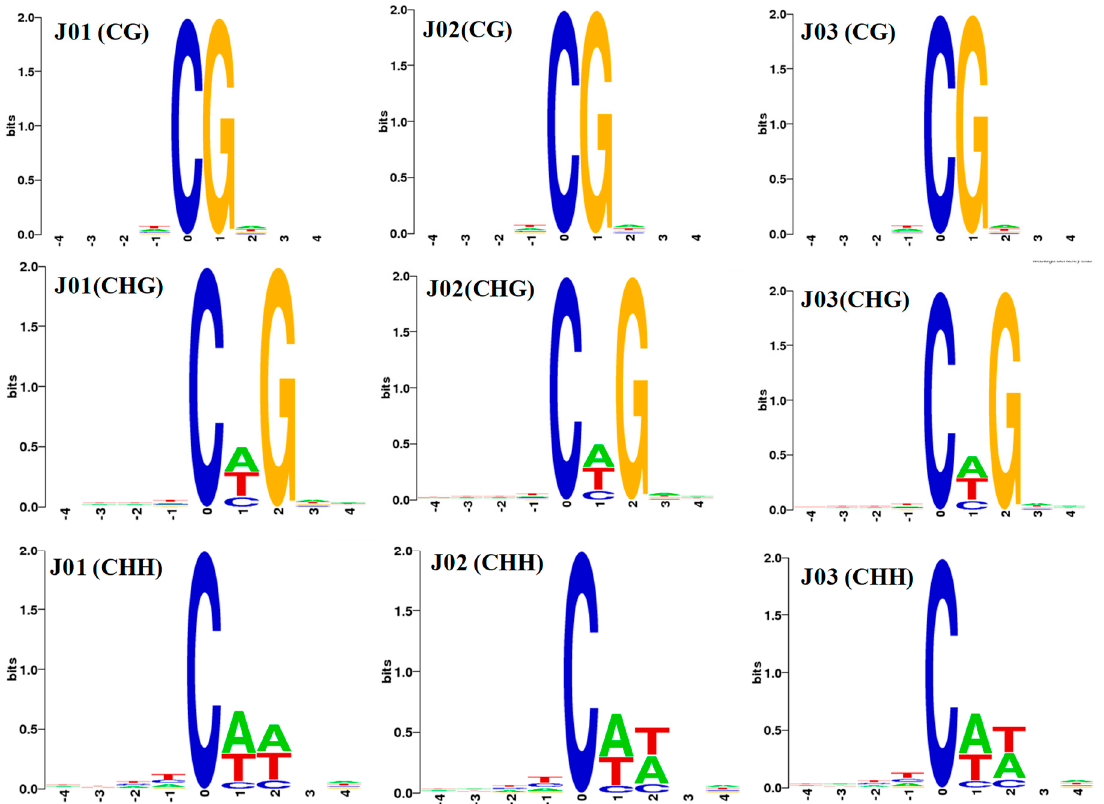
Figure 2. The methylation preferences in nine base pairs (bp) spanning methylcytosine sites. CG was the most common sequence motif at the CG mC sites (first row), CAG was the most common sequence motif at the CHG mC sites (second row), and CAT and CAA were the most common sequence motifs at the CHH mC sites (third row). The abscissa is the base number of the methylation site, and the total height of each position is the sequence conservation of the base, which represents the relative frequency of the base at that position.